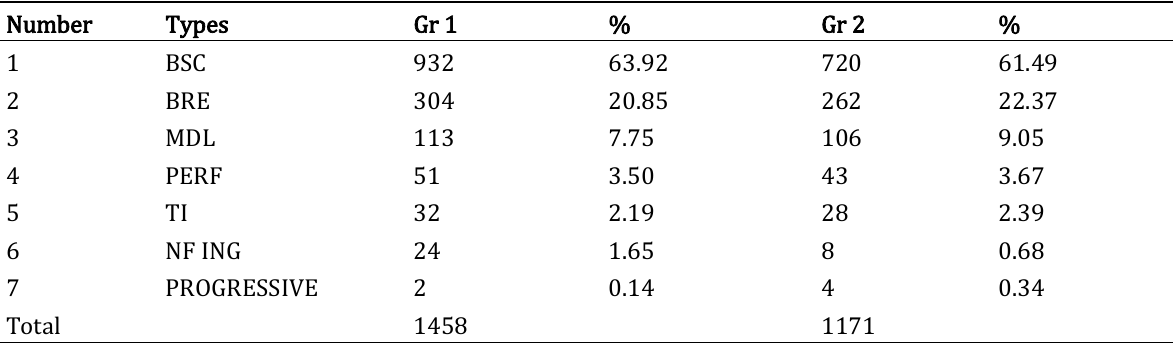
Table 1. Passive Voice Types and their